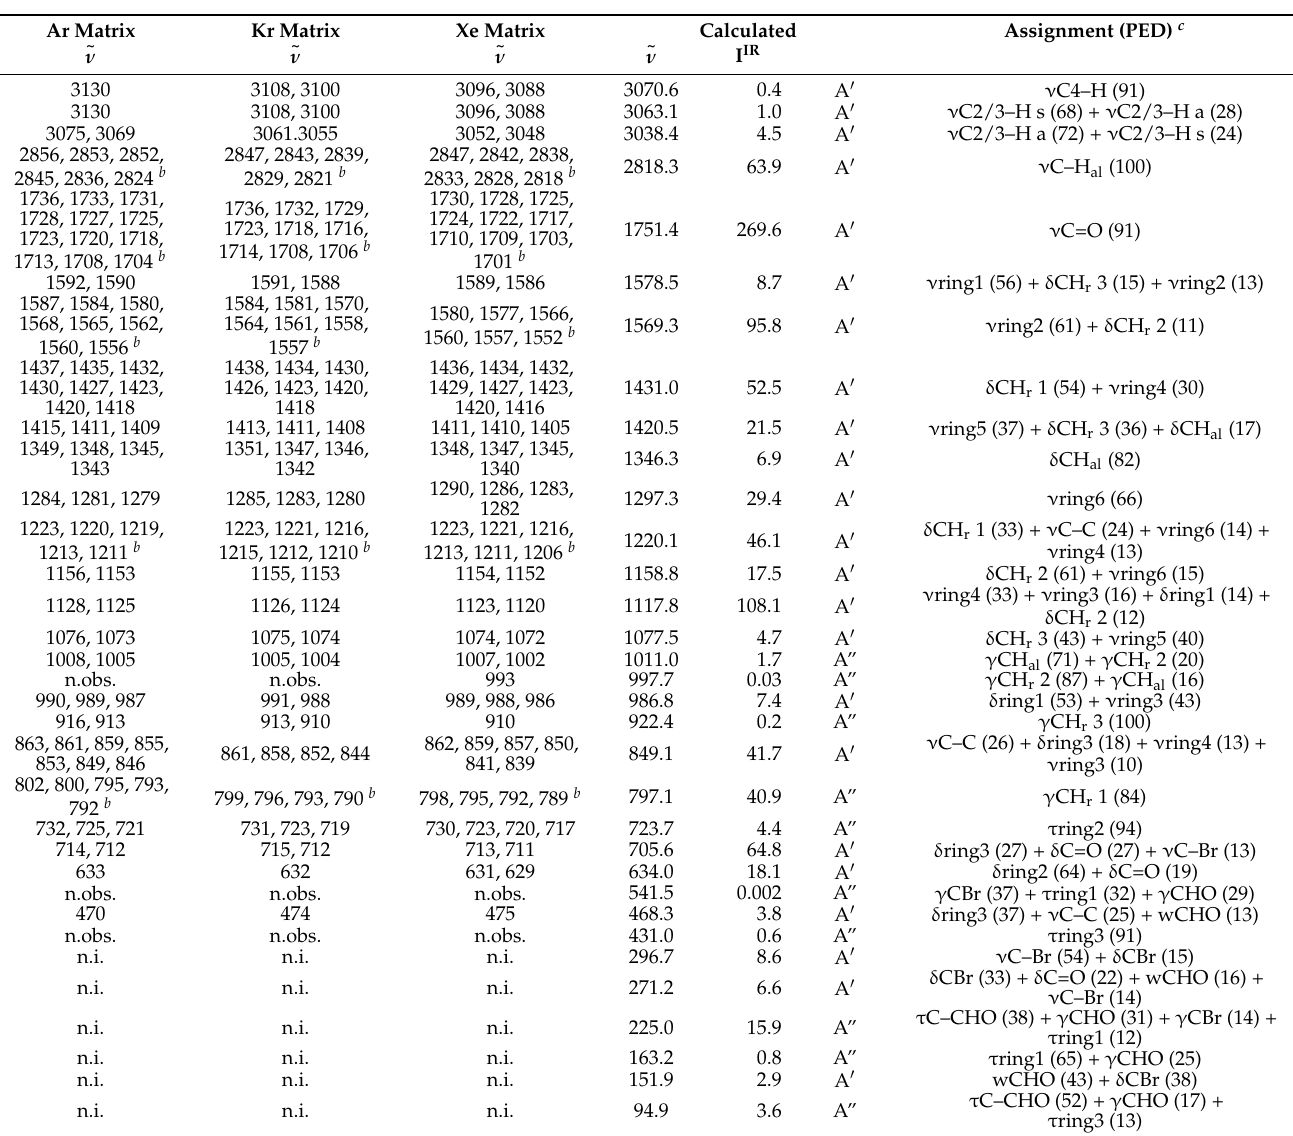
Table 2. Assignment of the IR spectrum of the as-deposited BPCA isolated in Ar, Kr and Xe matrices (conformer trans ) and calculated PEDs a